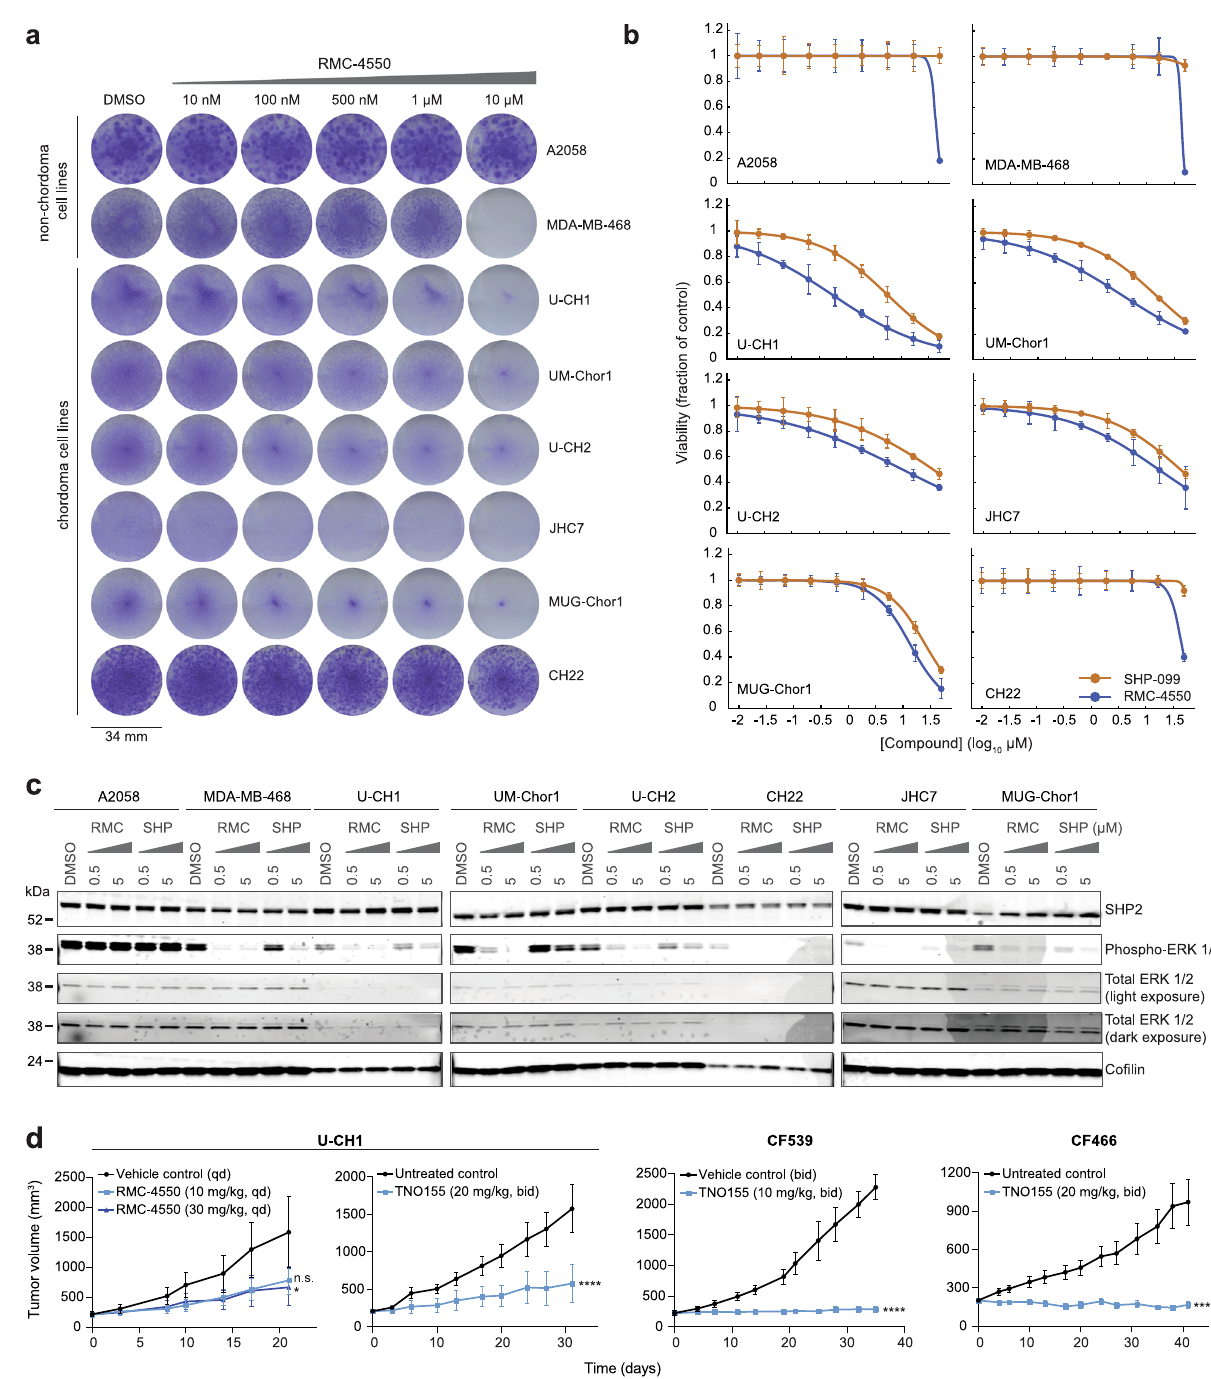
d Tumor proliferation in mice engrafted with chordoma cells (U-CH1 cell line- derived xenograft, CF539 PDX, or CF466 PDX) and treated with a SHP2 inhibitor (RMC-4550 or TNO155). Points represent the mean tumor volume±s.e.m. ( n =4 (control) or 5 (compound) tumors for each arm of the U-CH1/RMC-4550 study; n =6 (compound) or 7 (control) tumors for each arm of the U-CH1/TNO155 study; n =6 (control) or 7 (compound) tumors for each arm of the CF539 study; n =7 tumors for each arm of the CF466 study). n.s., not signi fi cant, * P <0.05, **** P <0.0001, derived from a two-wayanalysisof variance(ANOVA)withrepeated measures. P values for the time×treatment interaction (relative to the control condition)areindicated.Additionaldetailsof P valuesandeffectsizesarereported in Supplementary Data 7. Source data are provided as a Source Data fi le. See also related Supplementary Data